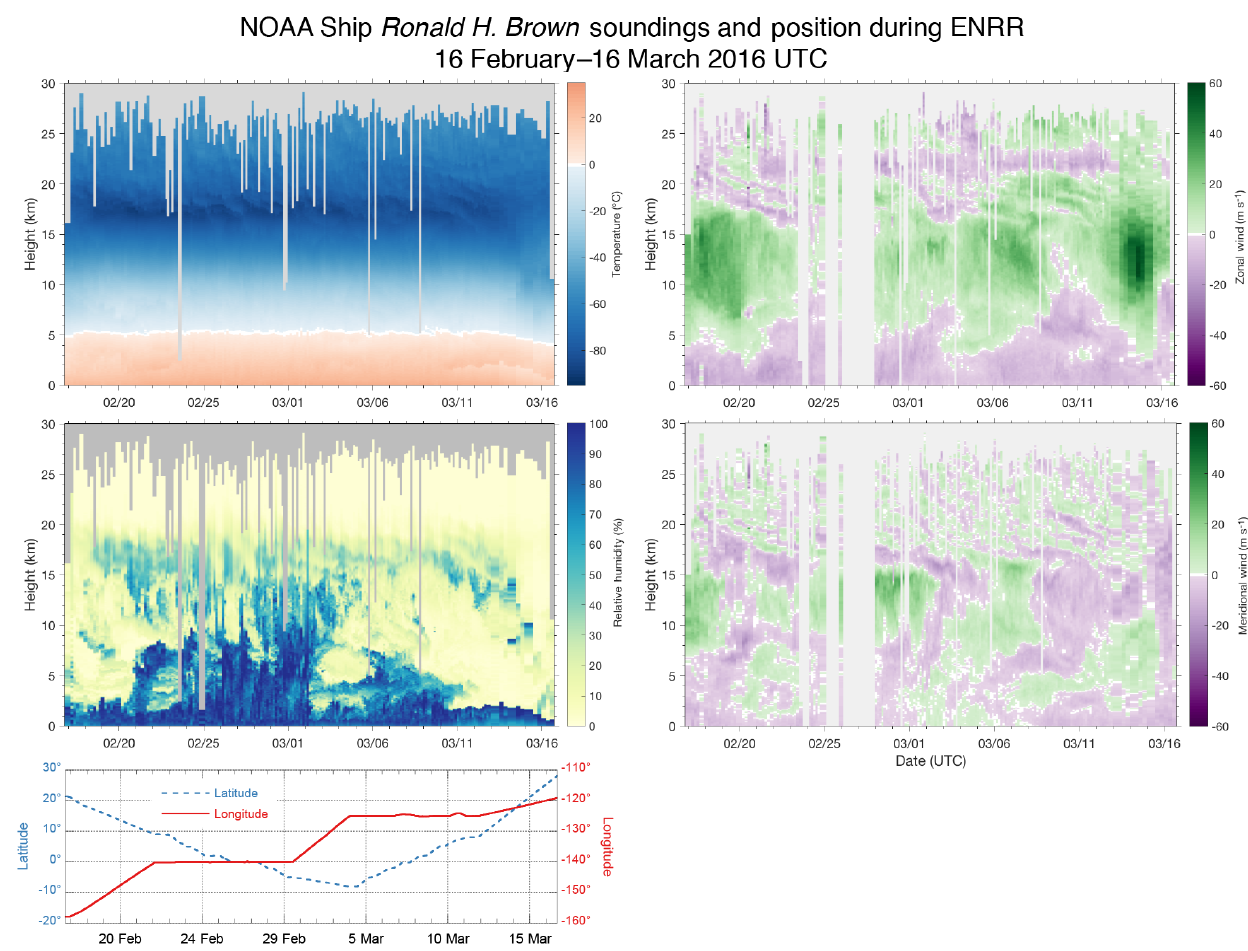
Figure 12. Vertical time–height sections of the temperature, relative humidity, and wind components measured by radiosondes launched from NOAA Ship Ronald H. Brown , together with the ship’s position (middle panel). Data from each sounding have been interpolated to a 25m vertical grid before plotting, and stretch along the x axis to completely fill the time between launches. The time between the penultimate and final launches is duplicated in the plotting of that final launch. Grey shading indicates no available data. Colors from www.ColorBrewer.org by Cynthia A. Brewer, Geography, Pennsylvania State